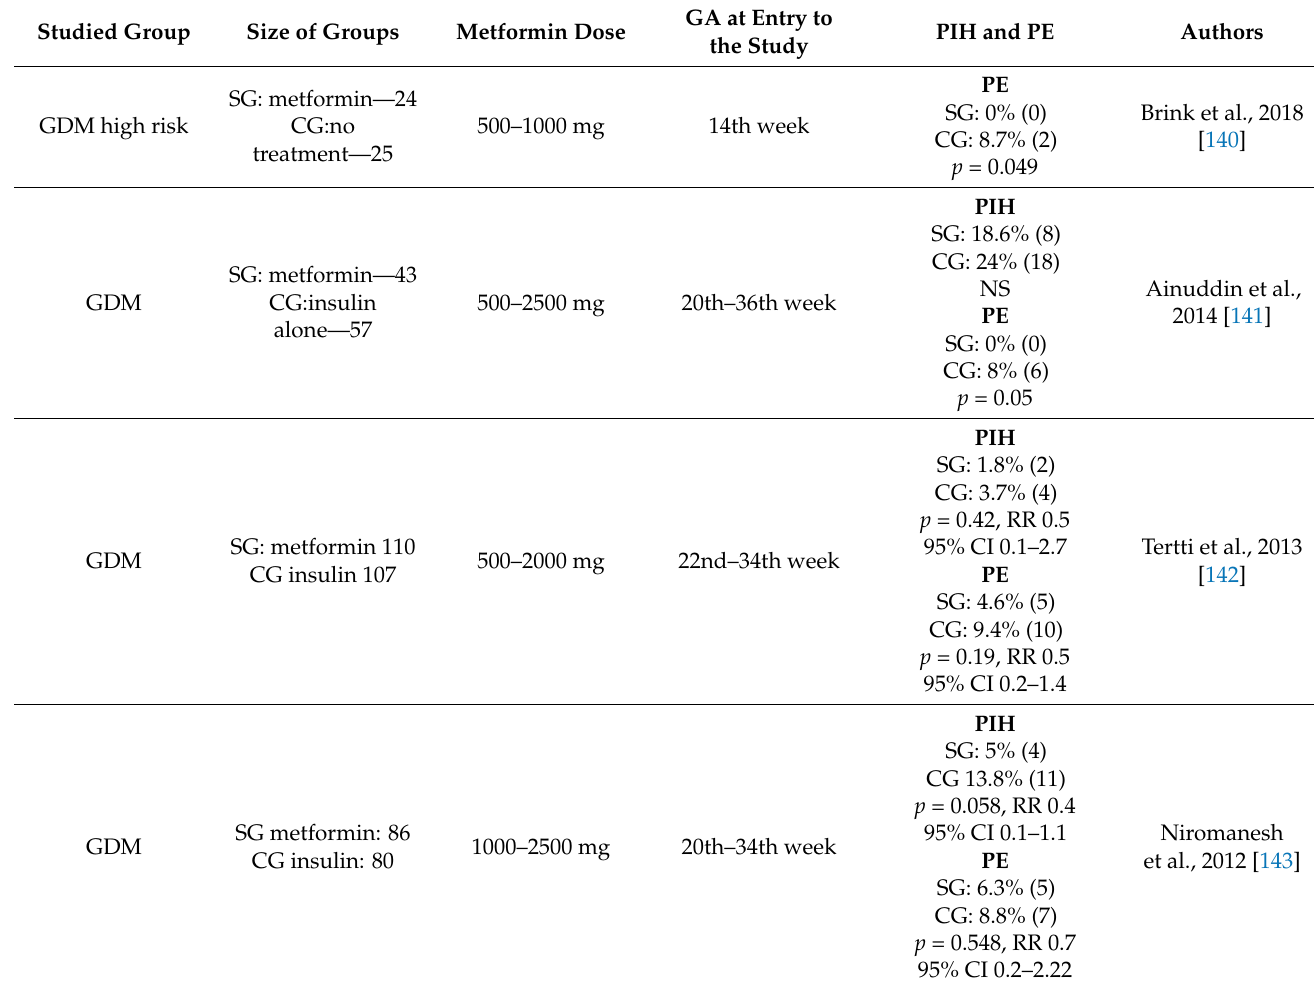
Table 1. Selected randomized placebo-controlled trials on metformin influence on PE and PIH incidence. Studied Group Size of Groups Metformin Dose